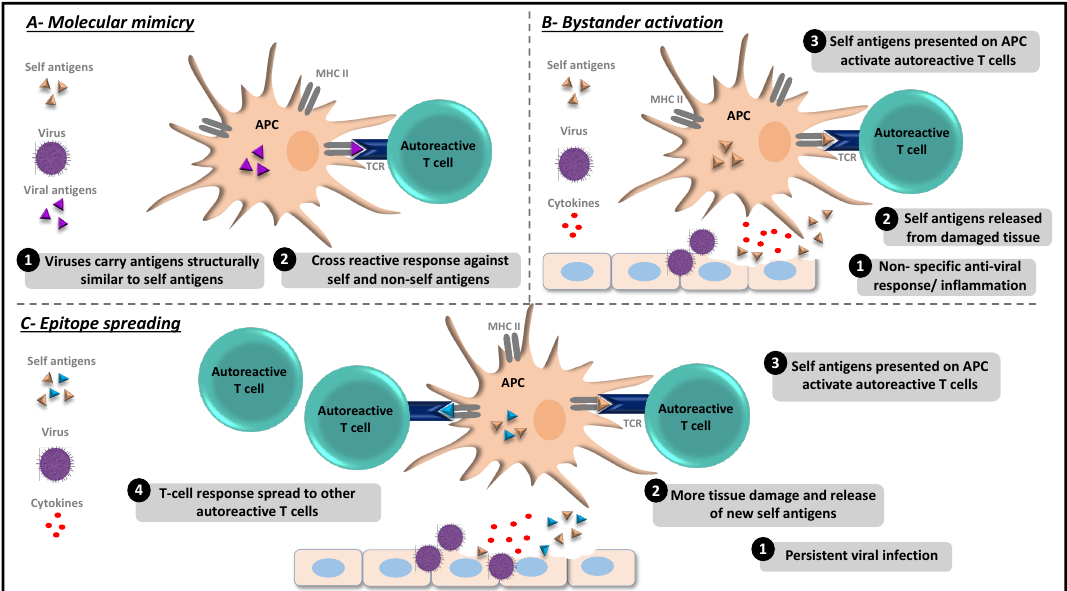
Figure 1. Mechanisms of virus-induced autoimmunity. ( A ) Molecular mimicry model: (1) Viruses carry epitopes structurally similar to self-epitopes. (2) Presentation of viral epitopes by antigen presenting cells (APCs) activate autoreactive T cells that bind to both, self and non-self-antigens, and induce tissue damage. ( B ) Bystander activation model: (1) Non-specific and over reactive antiviral immune responses lead to the liberation of self-antigens and release of inflammatory cytokines from the damaged tissue. (2) Self-antigen is taken up and presented by APCs. (3) Autoreactive T cells activated by APCs, leading to tissue destruction. ( C) Epitope spreading model: (1) Persistent viral infection. (2) Continued tissue damage and release of new self-antigens. (3) Self-antigens are taken up and presented by APCs. (4) Nonspecific activation of more autoreactive T cells leading to